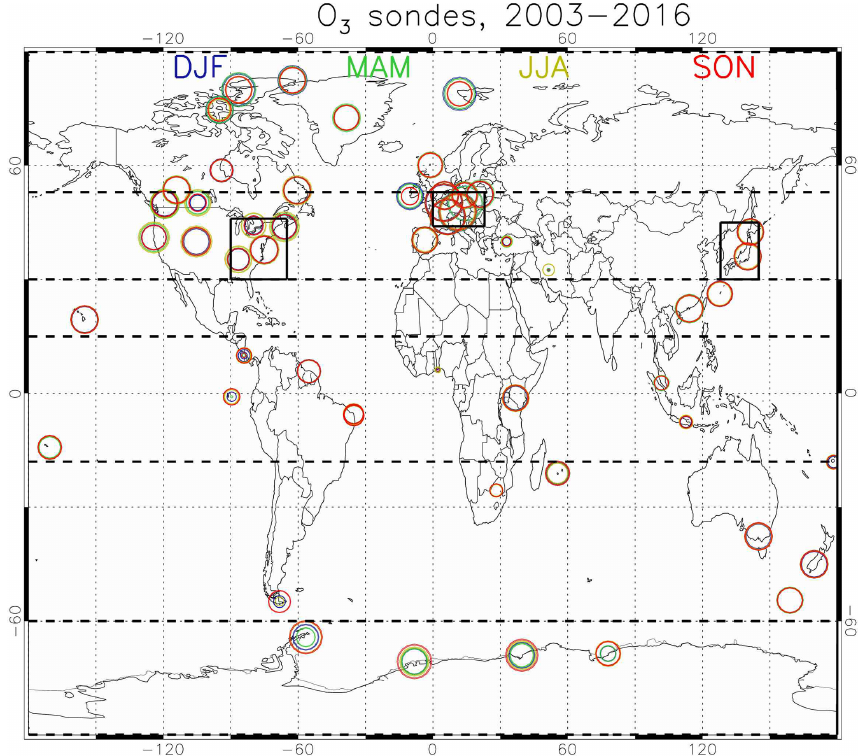
Figure 1. Locations of ozone-sondes contributing to the various regions. The size of circles indicates the relative number of observations contributing to the statistics for December–February (blue), March–May (green), June–August (yellow), and September–November (red). The dashed lines indicate the latitude bands representing the NH arctic region (53–90 ◦ N), NH mid-latitudes (30–53 ◦ N), NH subtropics (15–30 ◦ N), tropics (18 ◦ S–15 ◦ N), SH mid-latitudes (60–18 ◦ S), and Antarctic regions (90–60 ◦ S). The black boxes indicate three additional regions in the NH mid-latitudes: eastern US (90–65 ◦ W, 30–46 ◦ N), western Europe (0–23 ◦ E), and Japan (30–45 ◦ N, 128–145 ◦